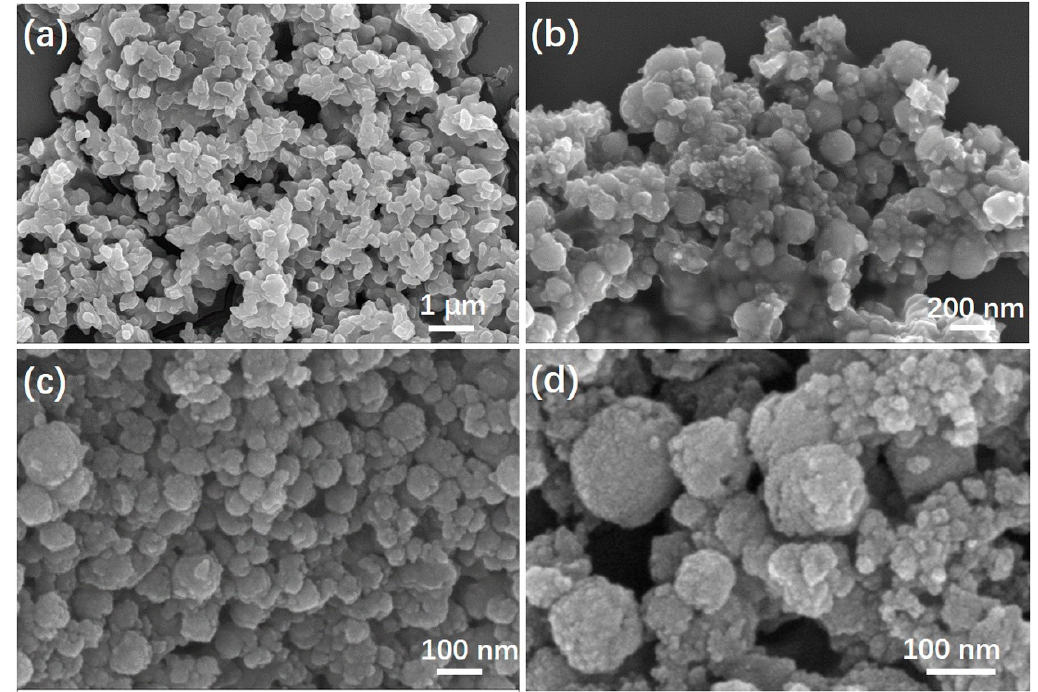
Figure 1. SEM images of ( a ) Ni-MOFs; ( b ) NiS 2 /C; ( c , d ) Fe-NiS 2 /C-30.